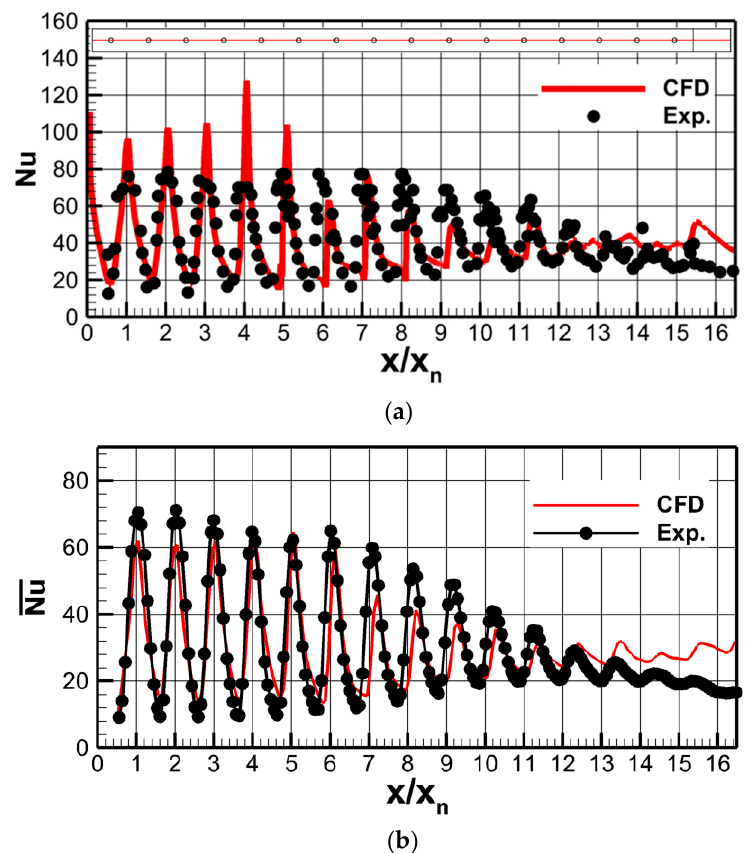
Figure 7. Validation of the turbulence model, Re j = 1.0 × 10 4 : ( a ) local Nu along the centerline and ( b ) spanwise-averaged Nu .